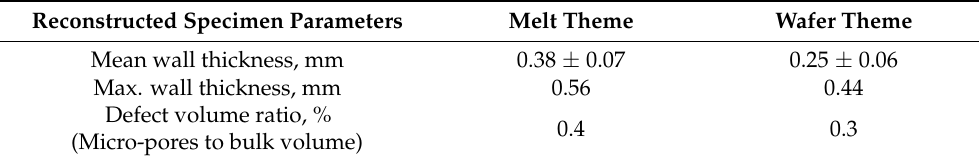
Table 2. Summary of the results of the quantitative image analysis of XCT data. (Measurement errors cannot be estimated; the error intervals represent the variance of all the measured